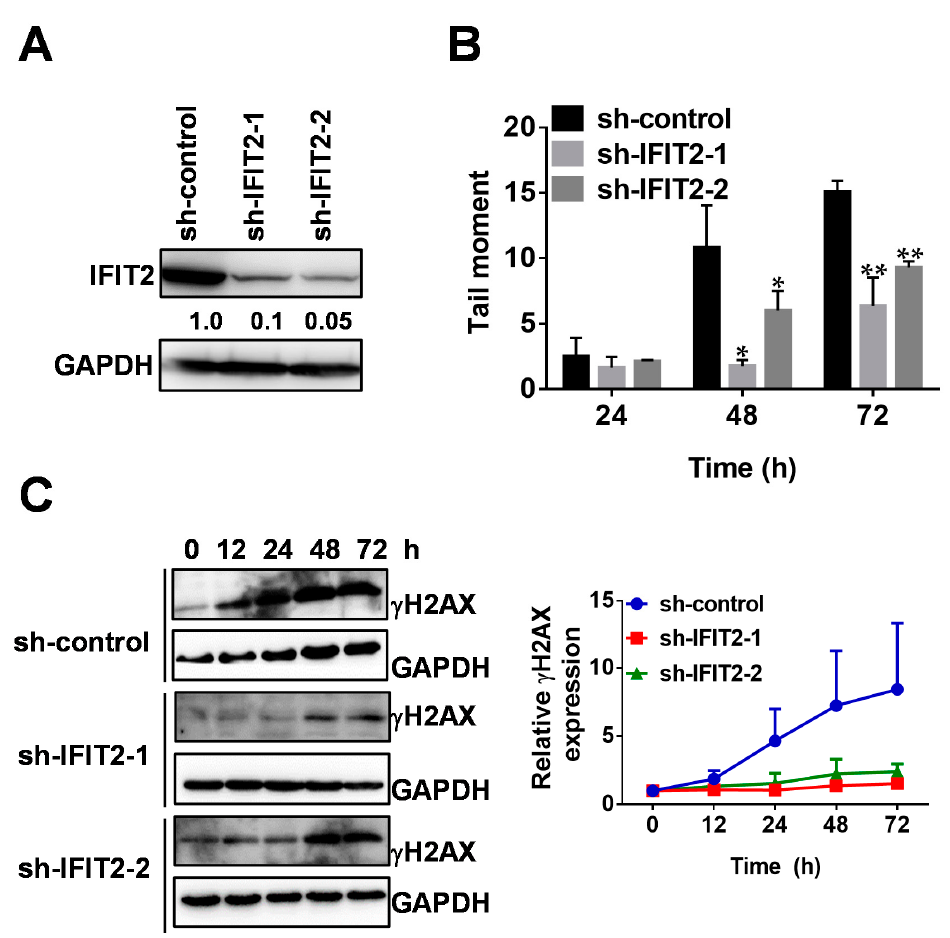
Figure 1. DNA damage in IFIT2-knockdown cells after 5-FU treatment. ( A ) IFIT2 expression in IFIT2-knockdown cells. The IFIT2 protein levels in sh-control, sh-IFIT2-1 and sh-IFIT2-2 cells were determined by Western blotting. GAPDH was used as a loading control. ( B ) Comet assay. Quantitative data from the comet assay. Data are presented as the mean ± SEM of three independent experiments. * p < 0.05, ** p < 0.01 compared with sh-control cells. ( C ) Induction of γ H2AX. Cells were treated with 5-FU for 12, 24, 48 and 72 h. The appearance of γ H2AX was determined by Western blotting. The right panel is the quantitative data of the of relative γ H2AX expression from three independent experiments.